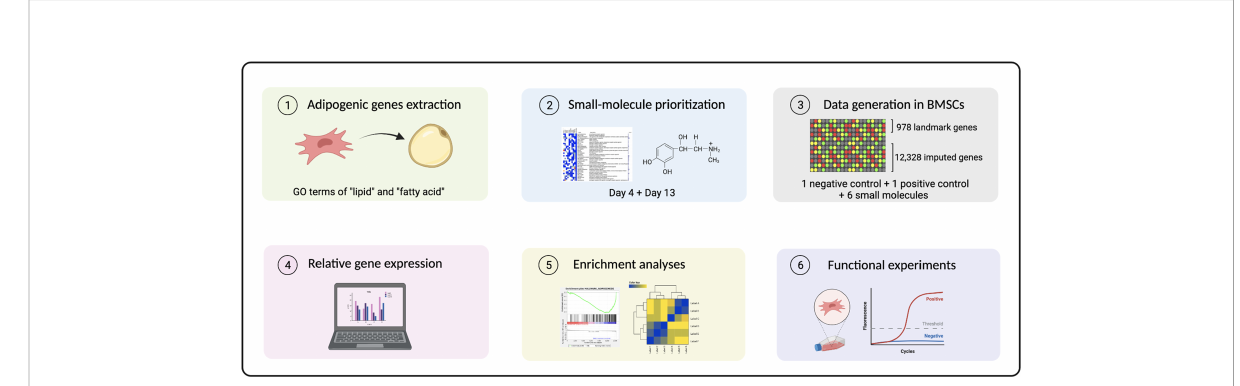
FIGURE 1 A schematic overview of analytical and experimental pipeline. 1 Differentially expressed (DE) probes at day 4 and day 13 annotated by GO terms “ lipid ” and “ fatty acid ” were extracted. 2 Small molecules were prioritized for further screening based on a connectivity-mapping strategy. 3 Transcriptomic pro fi les were generated in BMSCs using treatment with selected compounds using the L1000 platform. 4 Relative gene expression indicated using a robust Z-score, 5-6 together with enrichment analyses provided evidence for functional